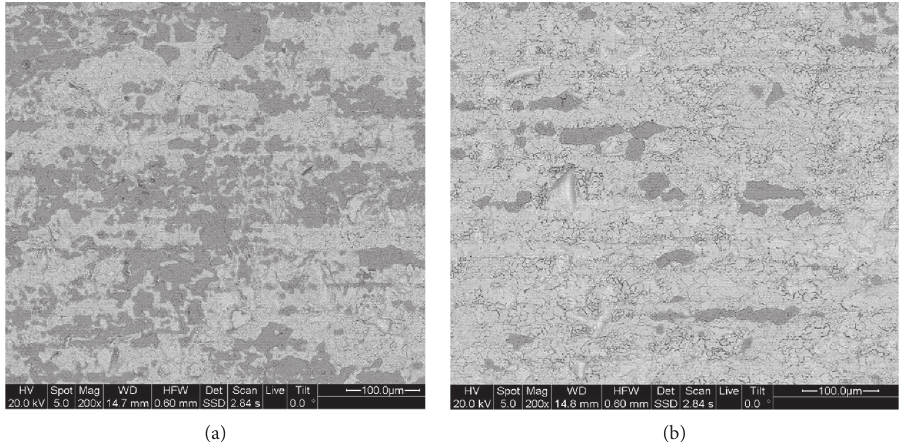
Figure 7: SEM surface images after static pickling in 300 gL − 1 H